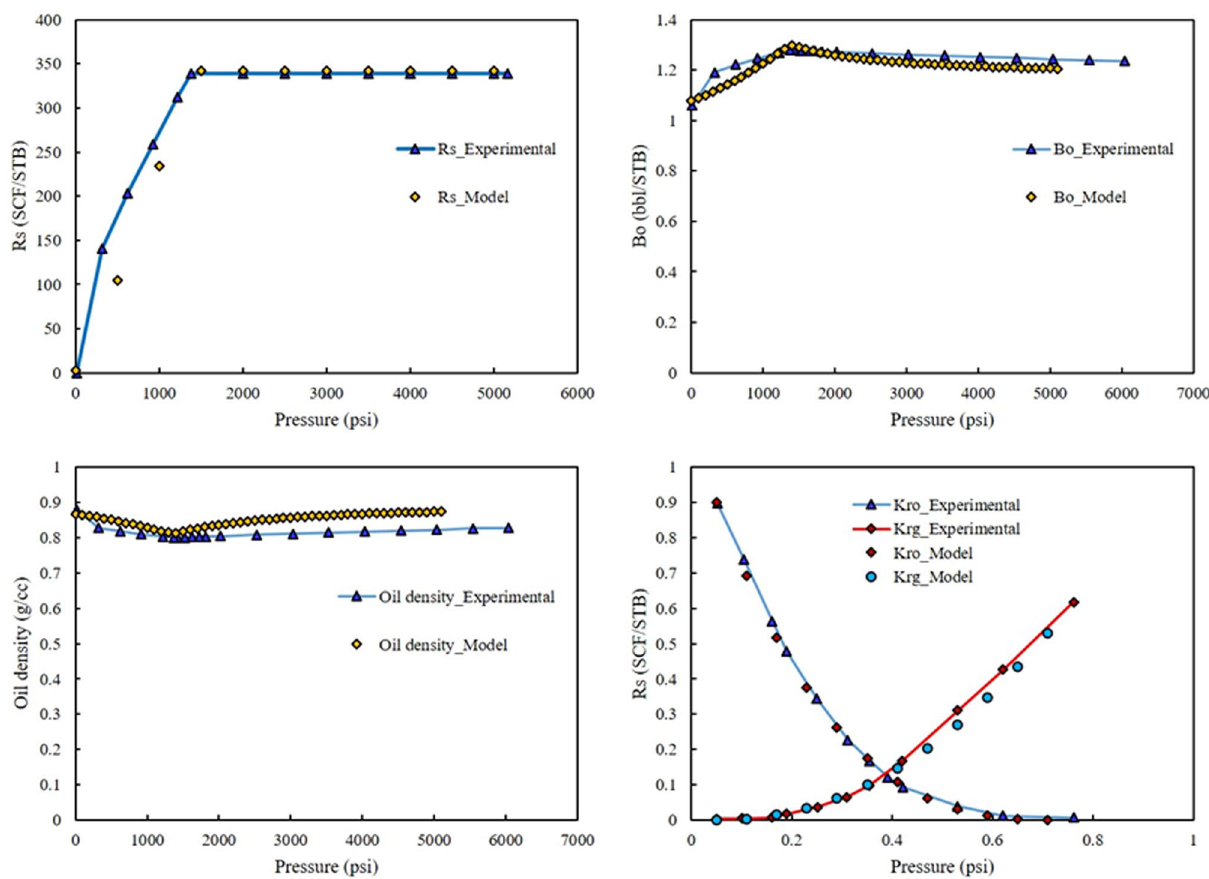
Figure 2. Comparison of the simulated value solution gas-oil ratio, oil formation volume factor, oil density, and relative gas and oil permeability.